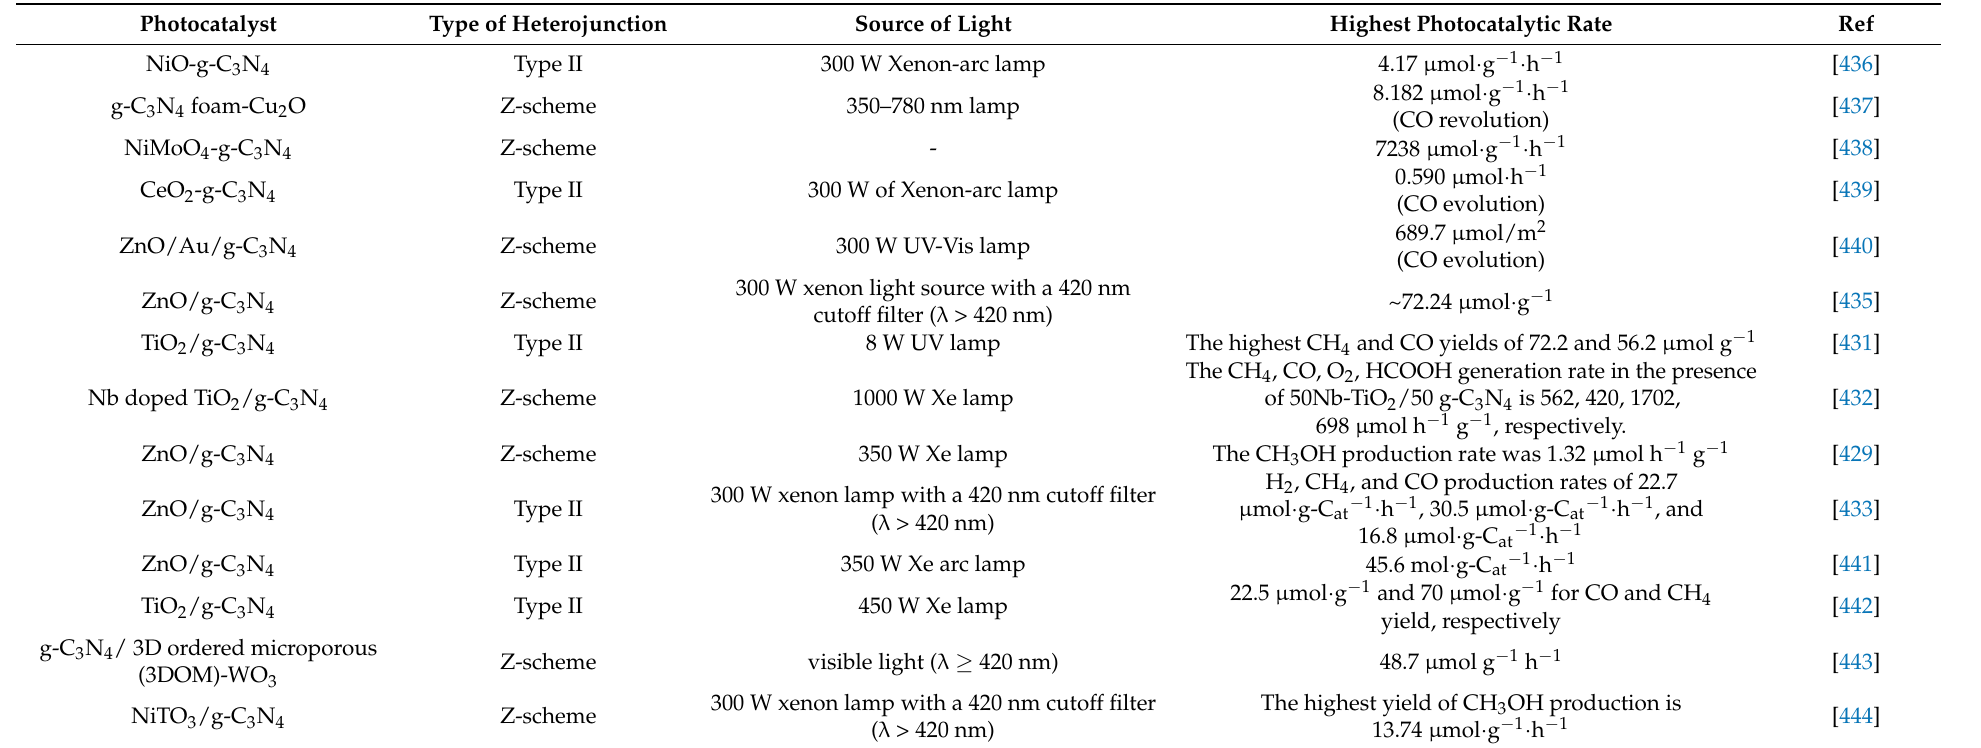
Table 3. A list of CO 2 reduction applications of the g-C 3 N 4 –metal oxide-based